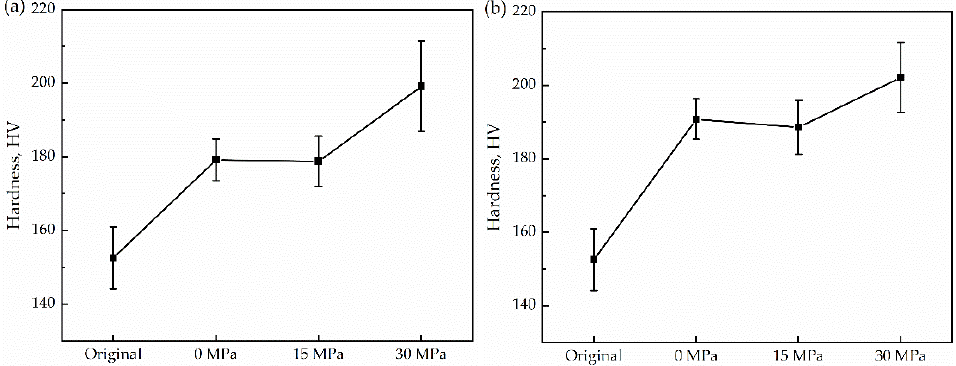
Figure 5. Evolution of Microhardness. ( a ) 25 K/min; ( b ) 50 K/min.